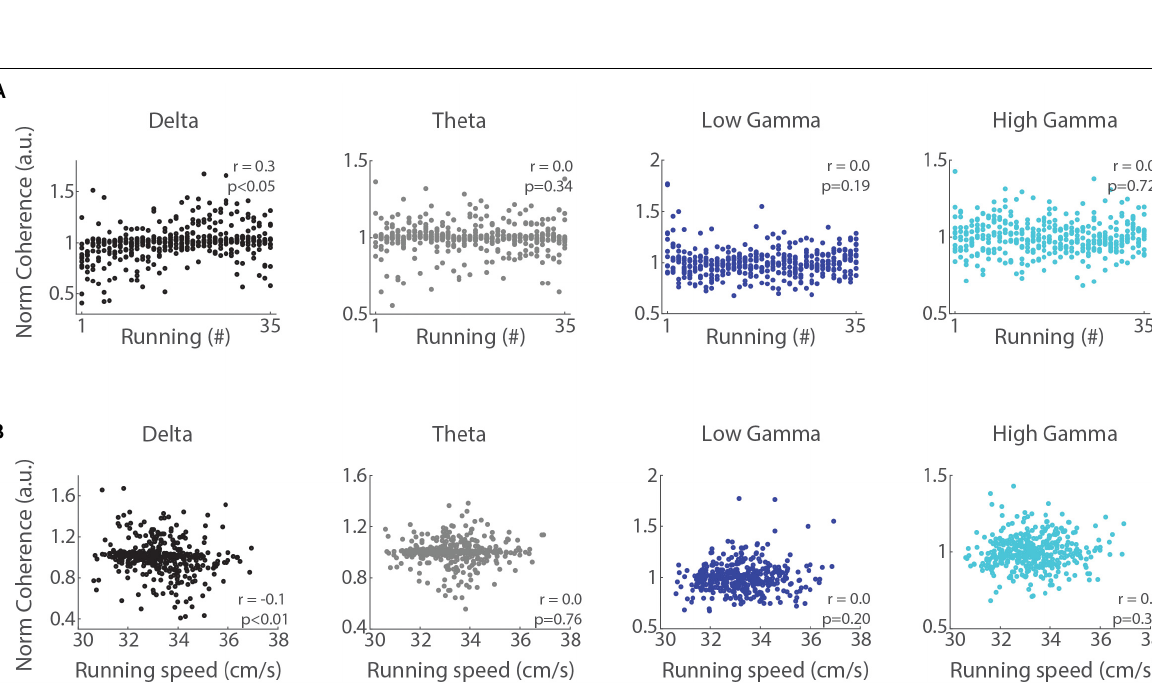
Frontiers in Behavioral Neuroscience |